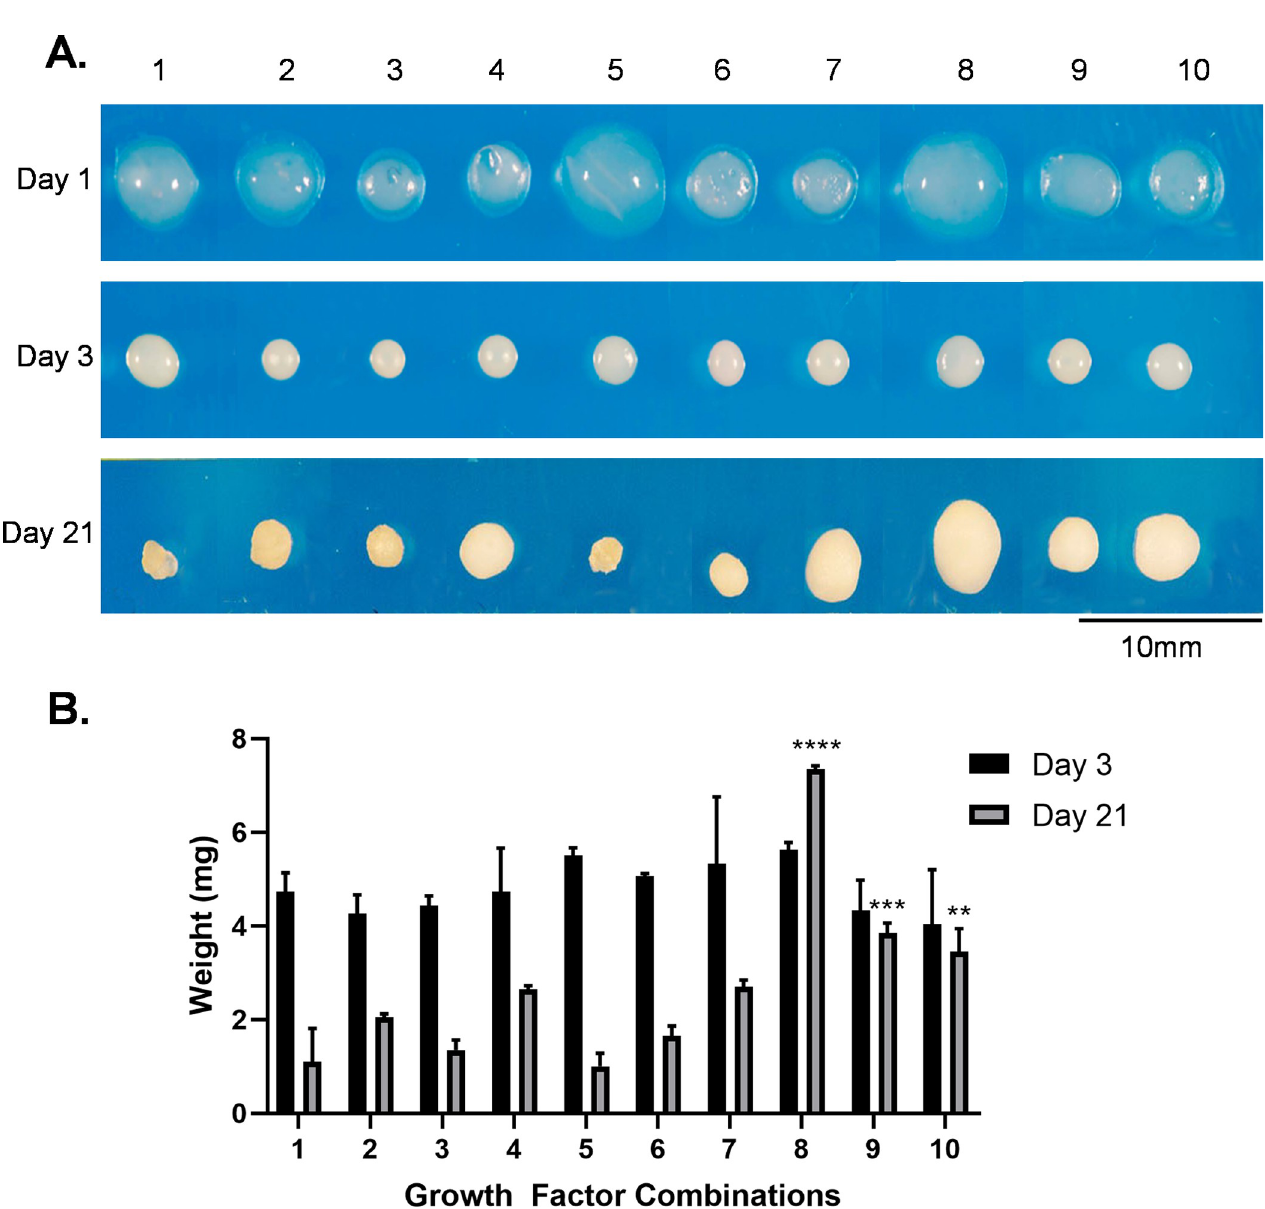
Fig 4. Gross photography and construct weight for initial chondrogenic screening. A) At day 1, 3, and 21, constructs were washed in PBS and transferred to a back-lit table for gross photography. B) At day 3 and 21, constructs (n = 3/condition) were dried to remove surface moisture and weighed to determine construct weight. No significant differences were detected across the treatment groups for day 3 construct weights. At day 21, treatment groups 8,9, and 10 were significantly greater than groups 1–7, represented by ���� (p < 0.001), ��� (p = 0.008), and �� (p = 0.044). Within treatment groups, there were significant differences in construct weight between day 3 and day 21 for groups 1–8; however, there were no differences between day 3 and day 21 weights for groups 9 (p = 0.9933) and 10 (p =